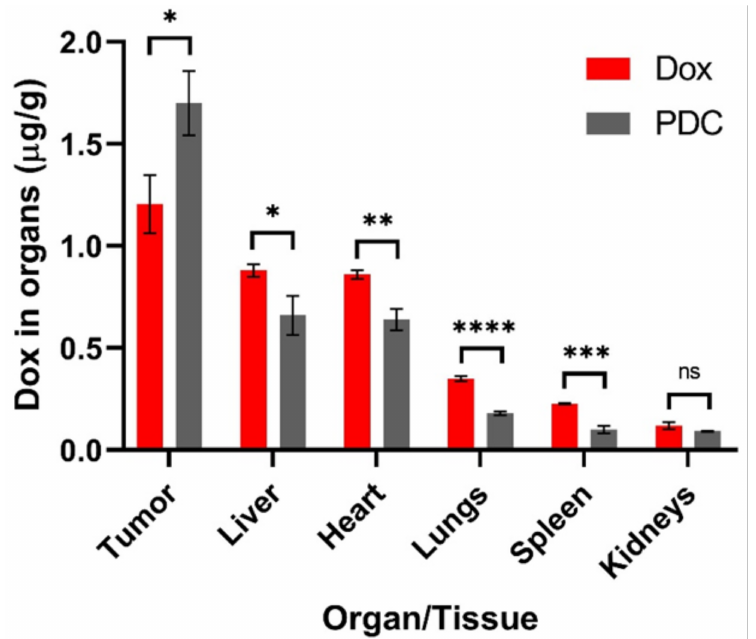
Figure 5. Biodistribution of Dox in tumor and other tissues at 24 h post injection (Dox or PDC). Data are presented as mean ± SD; n = 3; * p < 0.05, ** p < 0.01, *** p < 0.001, **** p < 0.0001, ns non-significant; Student t -test and one-way ANOVA were used. The significance level ( α ) was set at